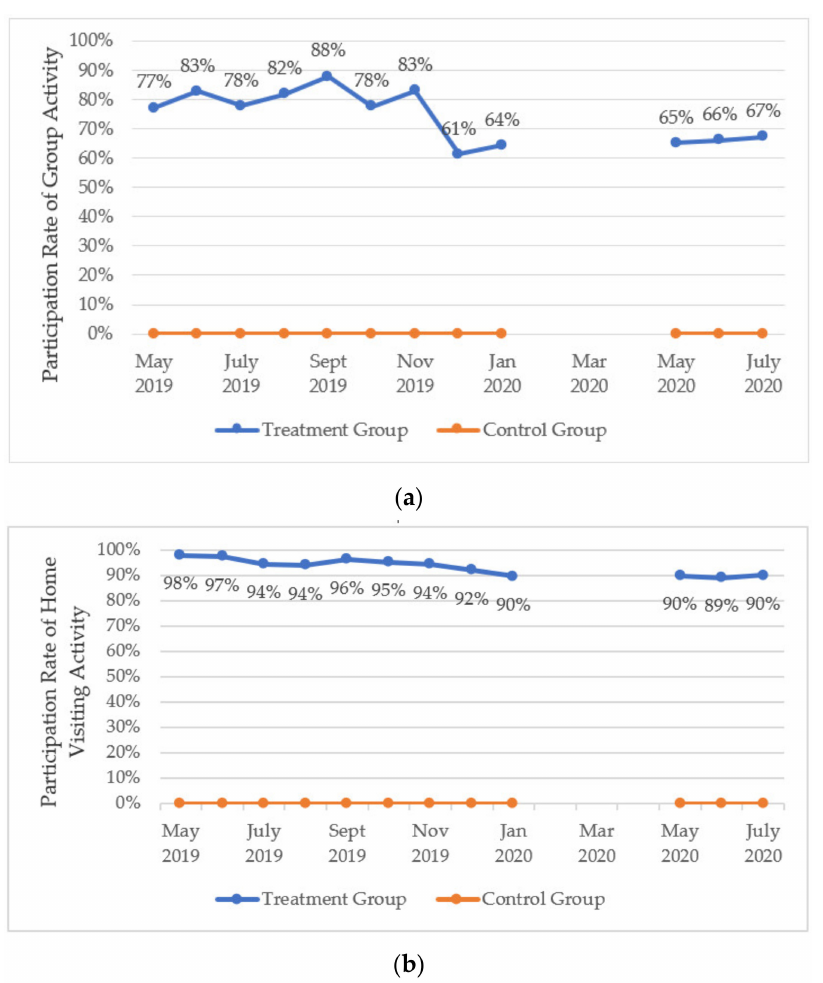
Figure 5. Participation rate of intervention activity: ( a ) Participation rate of group activity; ( b ) Participation rate of home visiting activity. Table 5. Local average treatment effect on the mental health of the caregivers who participated in group activities nine times or more and also participated in home visiting 22 times or